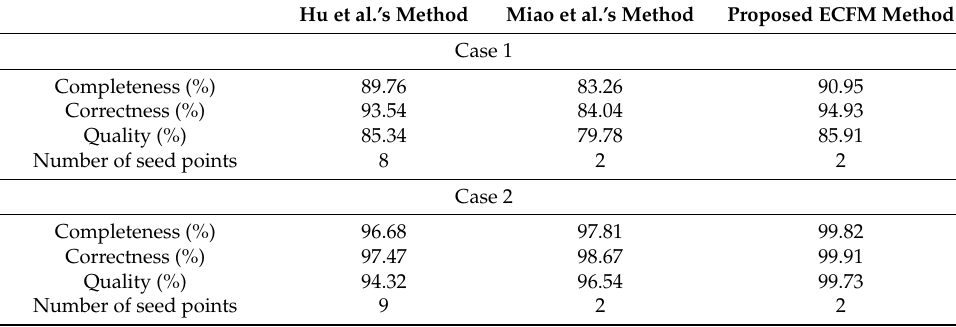
Table 1. Comparison of Three Semiautomatic Road Centerline Extraction Methods.